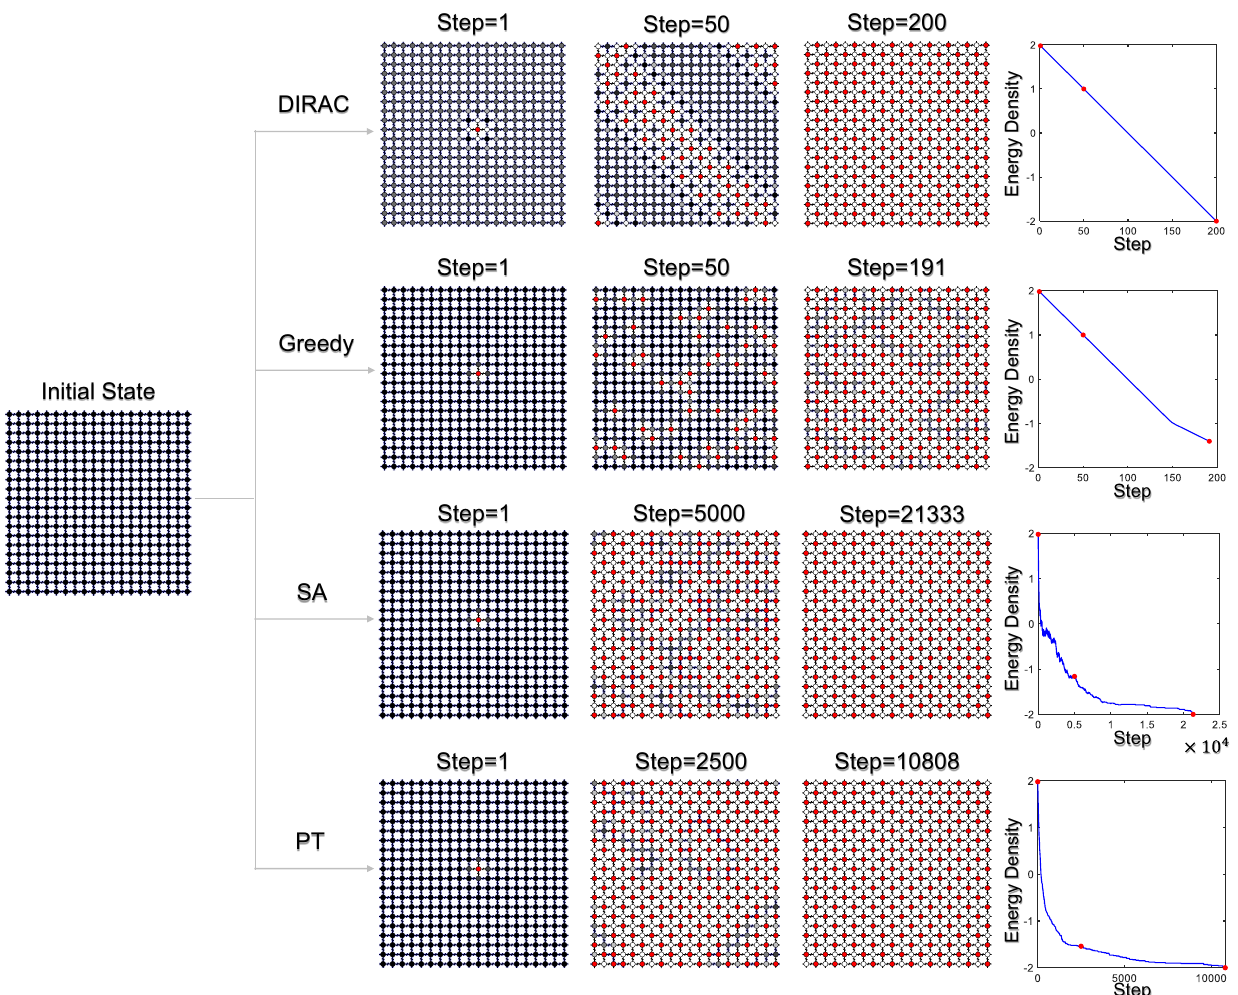
Fig. 7 | DIRAC attempts to mimic human intelligence in fi nding the ground stateoftheanti-ferromagnetic Ising modelwhereallcouplings J ij = − 1. Herewe demonstrated how different methods, namely DIRAC, Greedy, SA, and PT, reach the ground state in the case of anti-ferromagnetic Ising model where all couplings J ij = − 1. The PT snapshots and energy trend shown here were chosen from the lowest-temperature replica. Also, for SA, here we set the number of sweeps N s =1 (instead of 50) because for SA fi nding the ground state of the anti-ferromagnetic Ising modelisa relatively easy task w.r.t fi nding the spin glass ground state. Allthe differentmethodsstarted fromauniforminitialstate (theleftmostsnapshotinthe fi gure),whereallthespinvaluesaresettobe+1(black).Inthefollowingsnapshots, red sites represent sites with spin value − 1. The grayscale value was determined as follows:ForDIRAC,allthe Q -valueswererescaledtotherangefrom0(thesmallest Q -value, white) to 1(the largest Q -value, black); For Greedy, SA and PT, the site